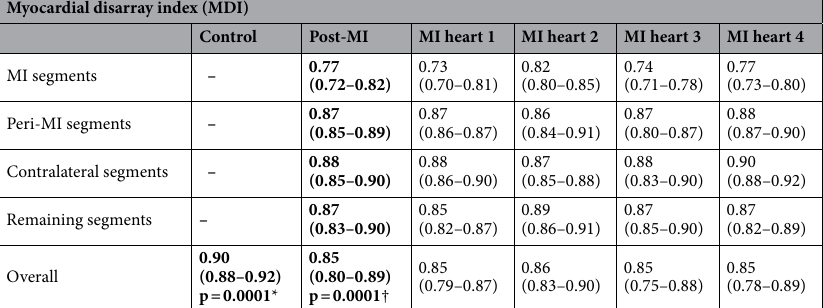
Table 2. Myocardial disarray index (MDI) in different regions of all hearts. MDI is calculated for 45 segments in each heart. Significant differences are observed in MDI between post-MI hearts (N = 4) and control heart (N = 1), as well as between different regions of post-MI hearts. Comparisons of MDI between segments were performed by a Kruskal–Wallis non-parametric test. All values are expressed as median with interquartile range. MI myocardial infarction. * p = 0.0001 for comparison between MDI in MI segments and peri-MI, contralateral, and remaining segments in comparison with MDI in control. † p = 0.0001for comparison between MDI in MI, peri-MI, contralateral and remaining segments of post-MI hearts.